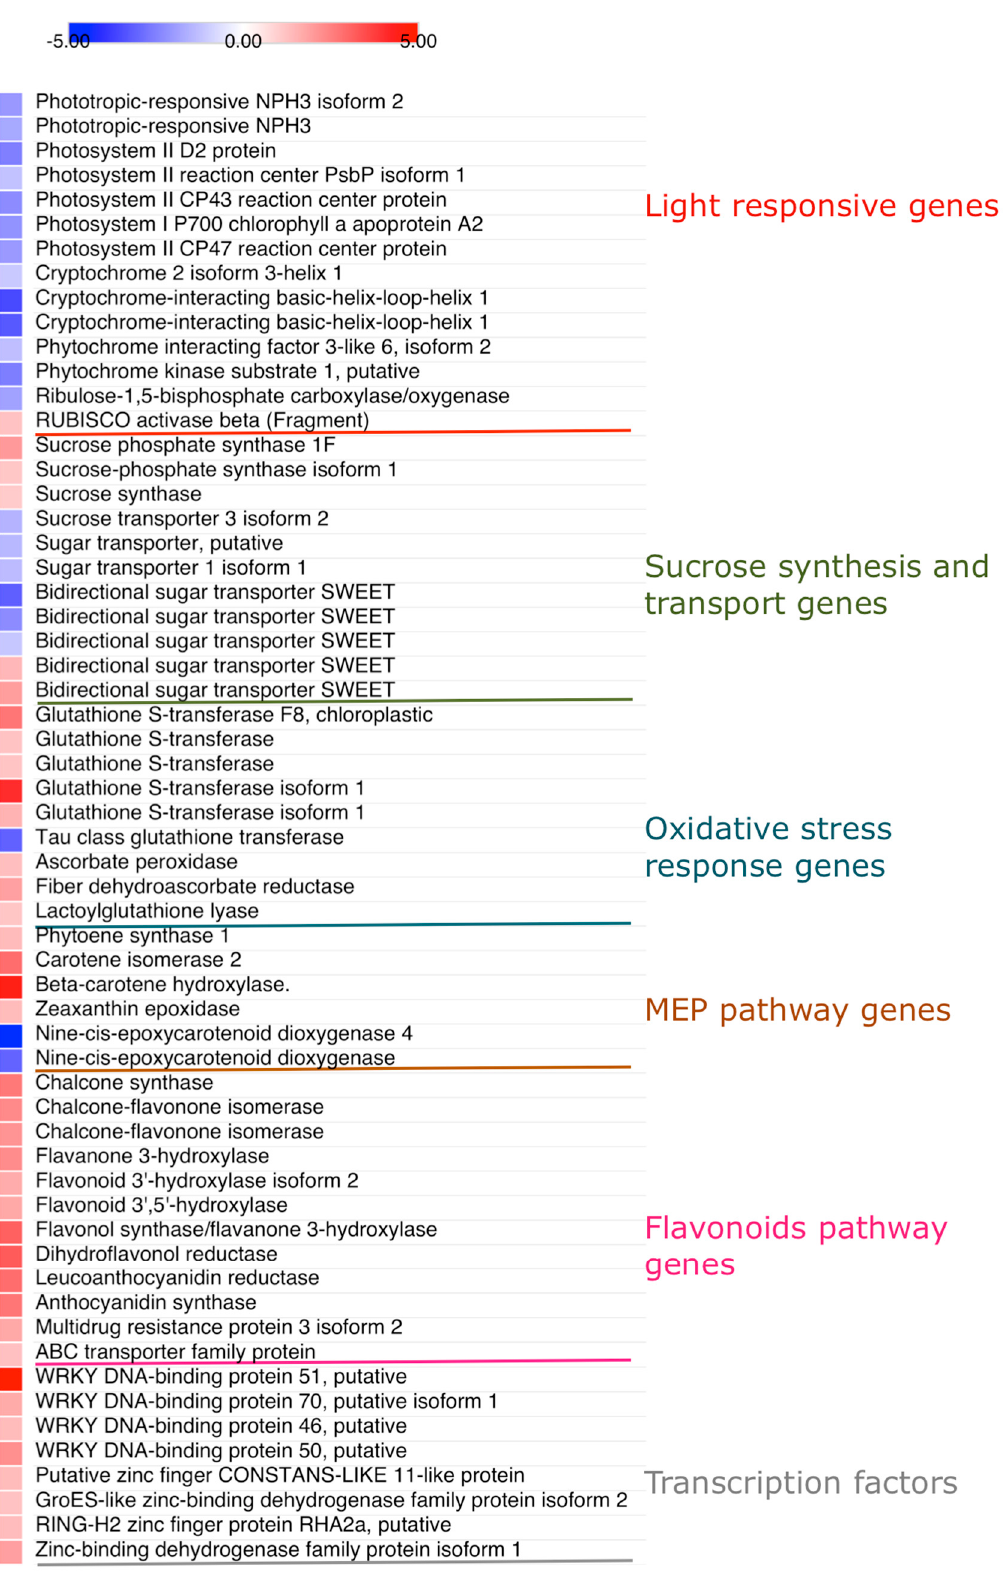
Figure 1. Heat map showing differentially expressed genes in C. incanus leaves adapted to shade or full sunlight. Fold changes, on log 2 basis, denotes sun to shade transcript abundance. In sun-exposed leaves the expressions of a suite of genes belonging to the family of Glutathione S-transferases ( GST ), which act as glutathione peroxidases and, hence involved in the detoxification of reactive oxygen species (ROS) were largely higher compared to shade-exposed leaves (Figures 1,2),